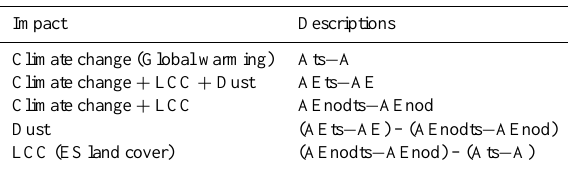
perturbed by dust in comparison to the surface reduction. Table 2. Impacts of climate change, land cover change and dust loading obtained by the difference between the experiments in this